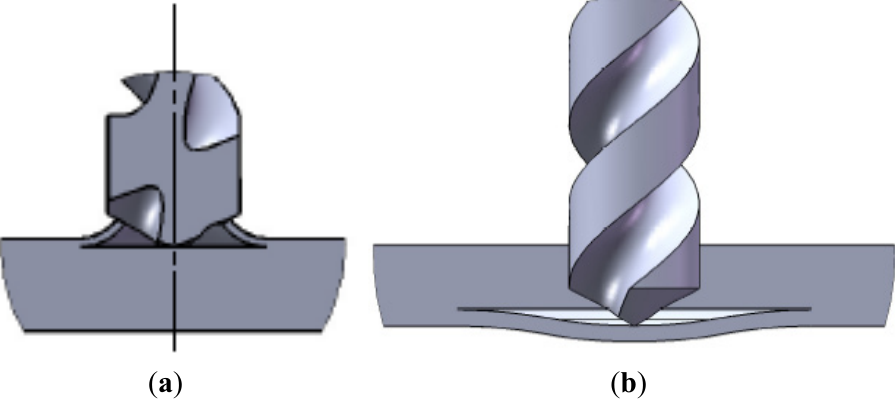
Figure 4. Delamination mechanisms: ( a ) peel-up delamination at entrance; ( b ) push-down delamination at